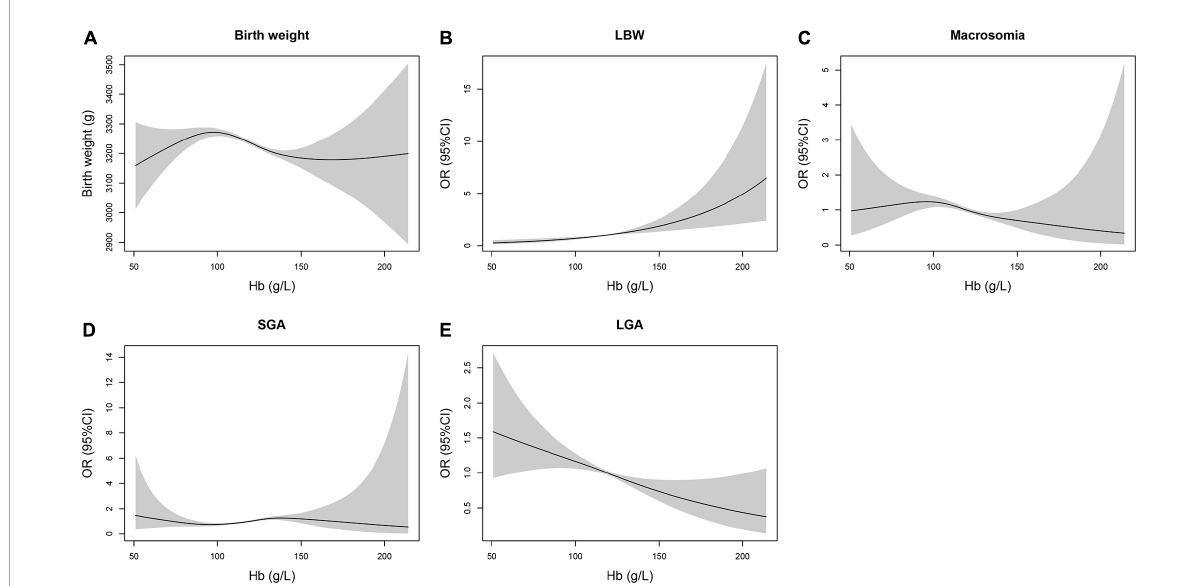
FIGURE1 Non-linear connections between maternal hemoglobin during the third trimester of pregnancy and birth weight outcomes in neonates. (A) Birth weight a , (B) LBW a , (C) macrosomia a , (D) SGA b , and (E) LGA b . a Adjusted for maternal age, occupation, ethnicity, educational level, parity, delivery mode, hypertensive disorders of pregnancy, GDM, neonatal gender, gestational age, and GWG. b Adjusted for maternal age, occupation, ethnicity, educational level, parity, delivery mode, hypertensive disorders of pregnancy, GDM, and